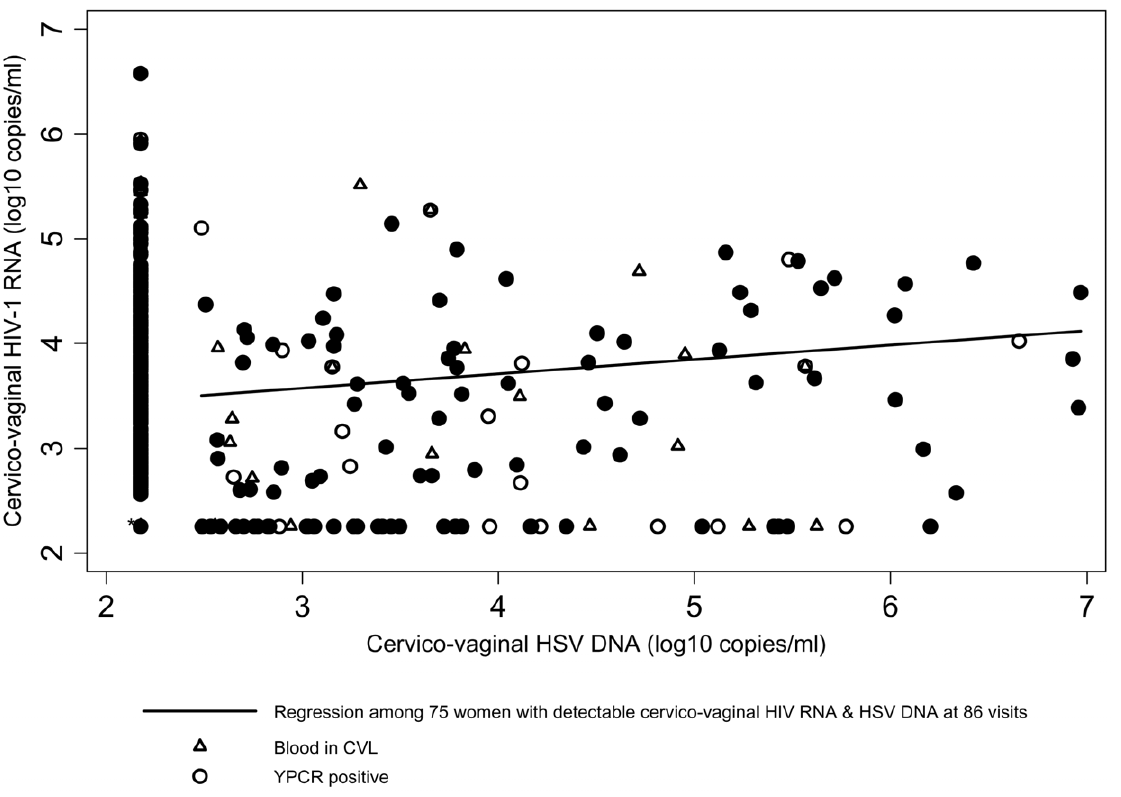
Figure 1. The relationship between cervico-vaginal HIV-1 RNA and HSV DNA among women with both viruses detected. Samples with visible blood or Y-PCR detected are indicated. Visits with undetectable HIV-1 RNA and HSV DNA were assigned a value of half the threshold of quantification. * This point marks 425 visits where HIV-1 RNA and HSV DNA were both undetectable.